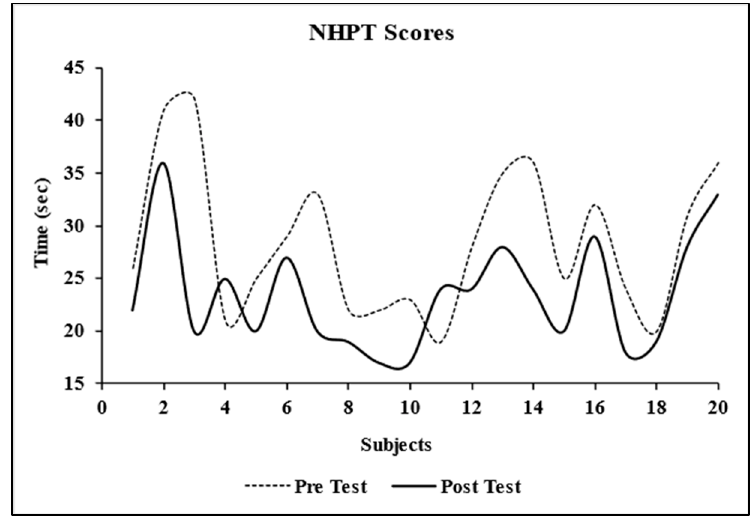
Figure 11. The pre and post-test scores of the Nine Hole Peg Test without and with splinting.